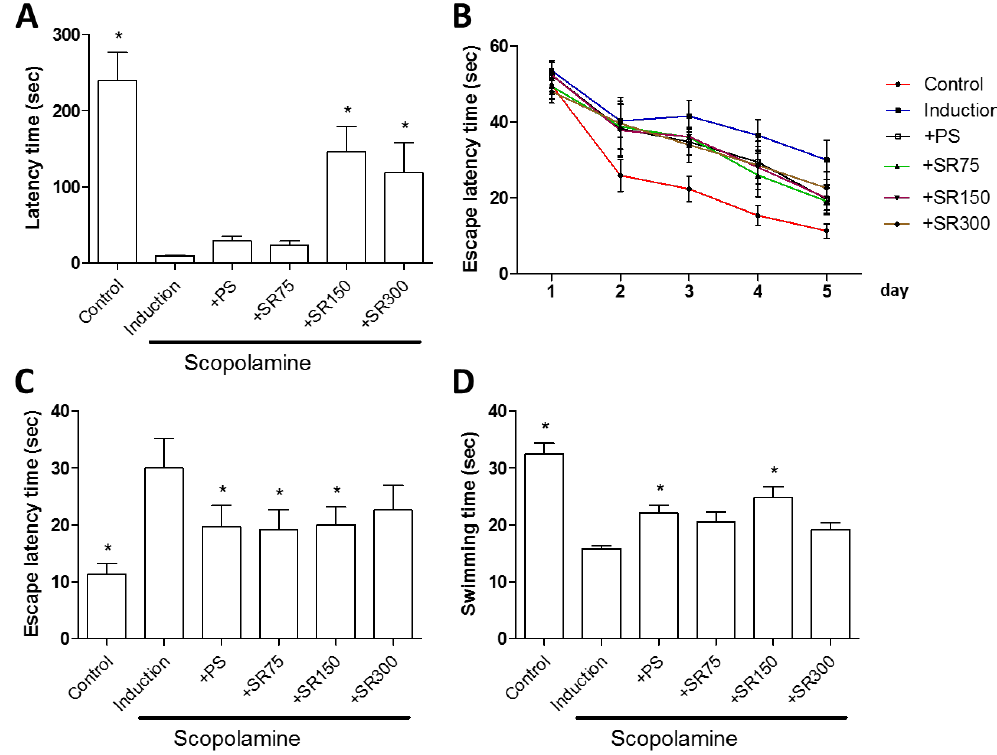
Figure 4. E ff ect of SC and RF extracts on scopolamine-induced cognitive impairment in scopolamine-treated rats. Rats were treated orally with SC + RF (SR) (75, 150, or 300 mg / kg / day) for 23 days and memory impairment was measured by the passive avoidance test and Morris water test. Fear motivation in the passive avoidance test was evaluated by latency time in scopolamine-treated rats ( A ). Escape latency time was measured daily for five days ( B ) and a significantly reduced escape latency time in SR treated-rats (75 or 150 mg / kg / day) was observed at day five ( C ). On the last day of the Morris water maze, swimming time in the target quadrant was measured ( D ). *: p < 0.05 vs. Induction. Abbreviation: PS,